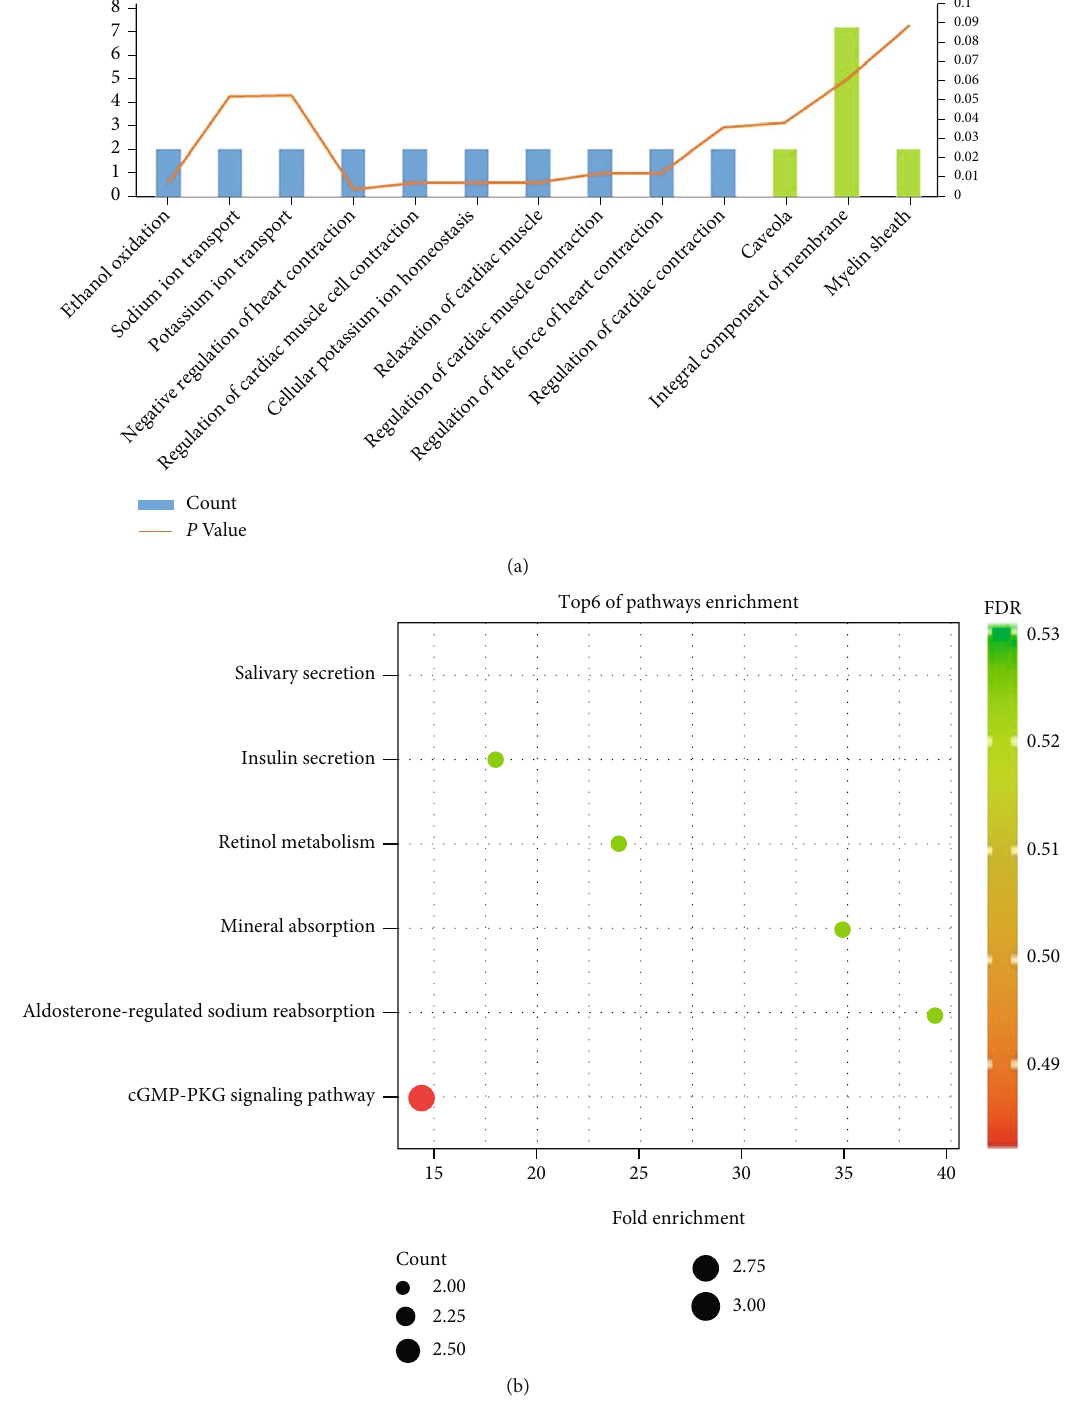
Figure 3: (a) GO analysis of DEGs in GIST. Thin blue bars represent biological processes (BP), and green bars represent cellular components (CC). The orange line represents p value. (b) KEGG analysis of DEGs in